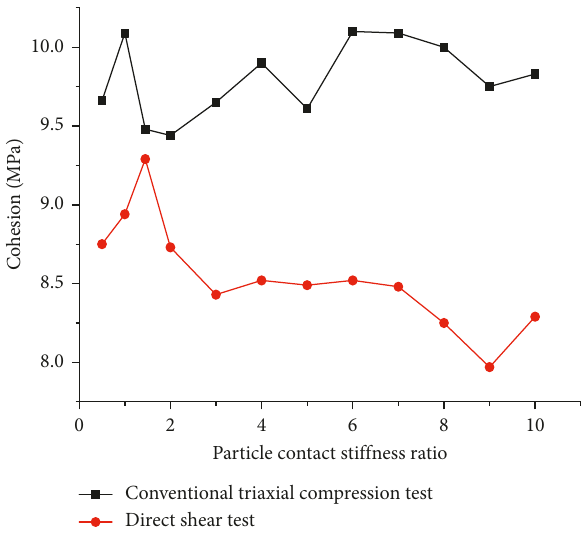
Figure 3: Influence of parallel bond stiffness on friction angle.